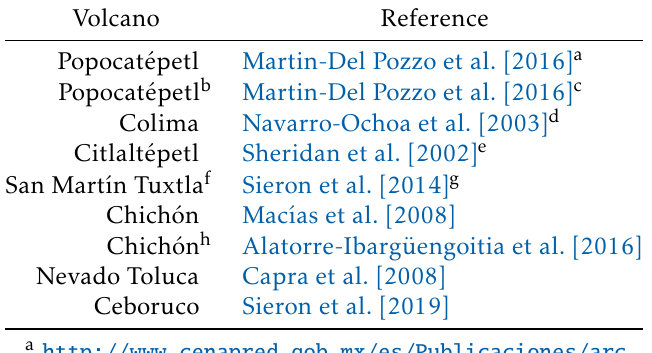
Table 3: Hazard maps of Mexican volcanoes. All online resources accessible as of January